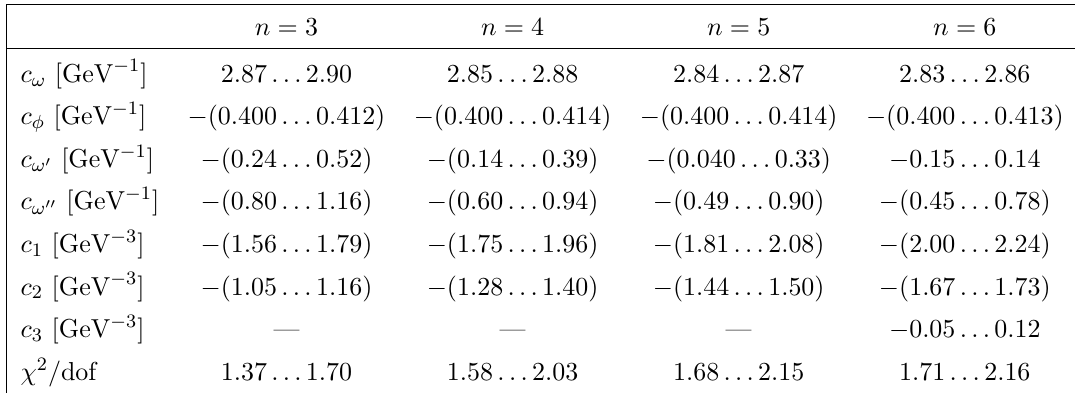
3 (cid:25) (cid:12)ts to SND+BaBar [130{132] using !